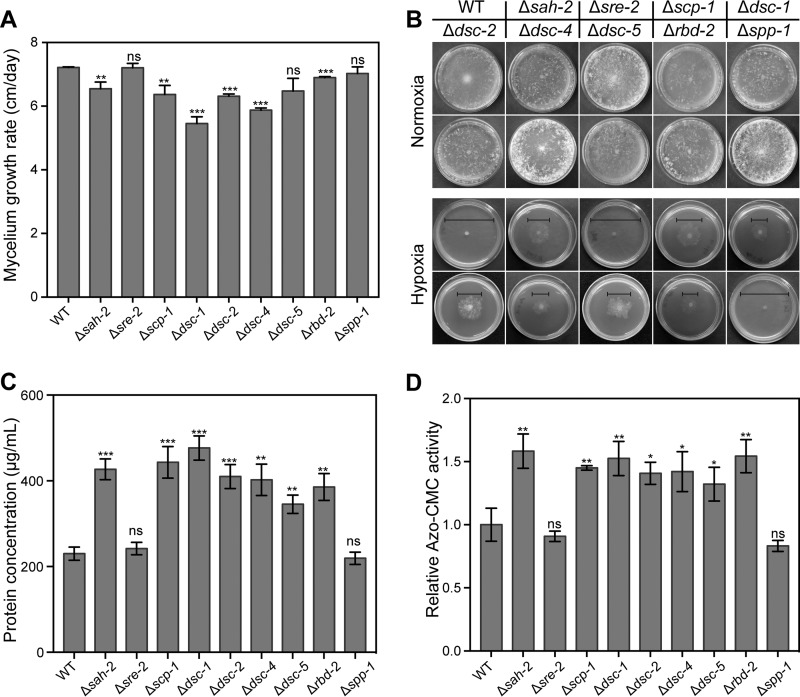
Phenotypic analysis of the potential SREBP-related mutants. (A) Growth rates of the WT and SREBP-related mutants. A suspension of 103 conidia from the strains indicated was inoculated into race tubes containing VMM and incubated for 3 days. Mycelium length was measured every 24 h (B) Growth of the WT and SREBP-related mutants on VMM under normoxic and hypoxic conditions (0.2% O2 in N2). A suspension of 103 conidia was inoculated into each plate, and growth was observed after 48 h of incubation. The solid line indicates the diameter of each colony. The plates shown represent the replicates of each strain, and the statistical analysis of colony diameter is shown in Fig. S1A. (C, D) Total secreted protein levels (C) and endoglucanase activities (D) in the supernatant of 96-h cultures in VMM with 2% Avicel after a shift from a 16-h VMM culture. Shown are the mean values of three replicates. Error bars show the standard deviations between these replicates. The significance of differences between the mutants and the WT was based on t test analysis by the FDR approach. Asterisks indicate significant differences (*, P < 0.05; **, P < 0.01; ***, P < 0.001). ns, not significant. Azo-CMC, azo-carboxymethyl cellulose.